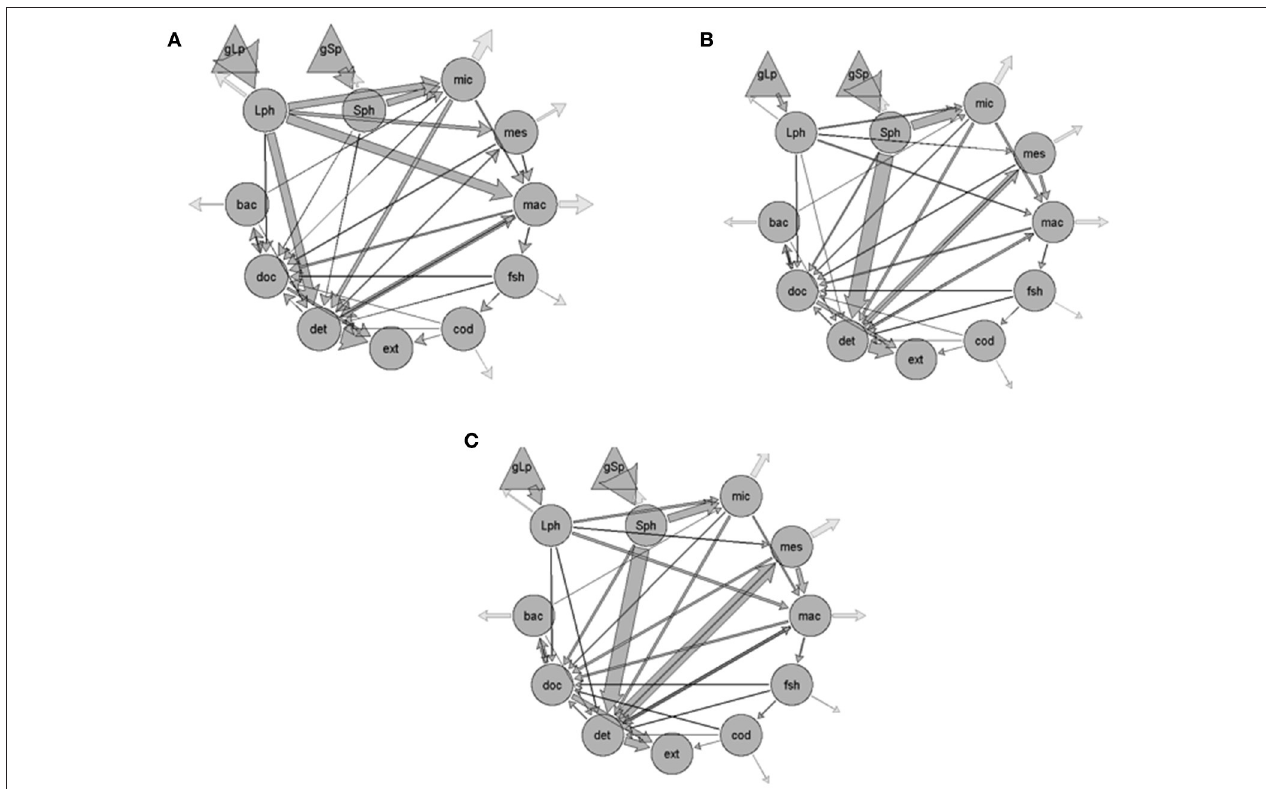
FIGURE 2 | Flows of carbon (mgC m − 2 d − 1 ) through the food web of the West Spitzbergen Current in the eastern Fram Strait (A) before, (B) during, and (C) after the warm water anomaly of 2005–2007. Primary productivity was dominated by the large phytoplankton (Lph), primarily diatoms, before the warm event and by small phytoplankton (Sph; primarily Phaeocystis ) during and afterwards. Phytoplankton were grazed by microzooplankton (mic), mesozooplankton (mes), and macrozooplankton (mac). Planktivorous fish (fsh) and cod (cod) generally consumed the larger grazers. Carbon could flow to detritus (det) as particulate material, or be remineralized as dissolved organic carbon (doc) to fuel bacterial productivity (bac). Gray arrows to nowhere represent respiration losses. gLp, gross primary productivity of the Lph; gSp, gross primary productivity of the